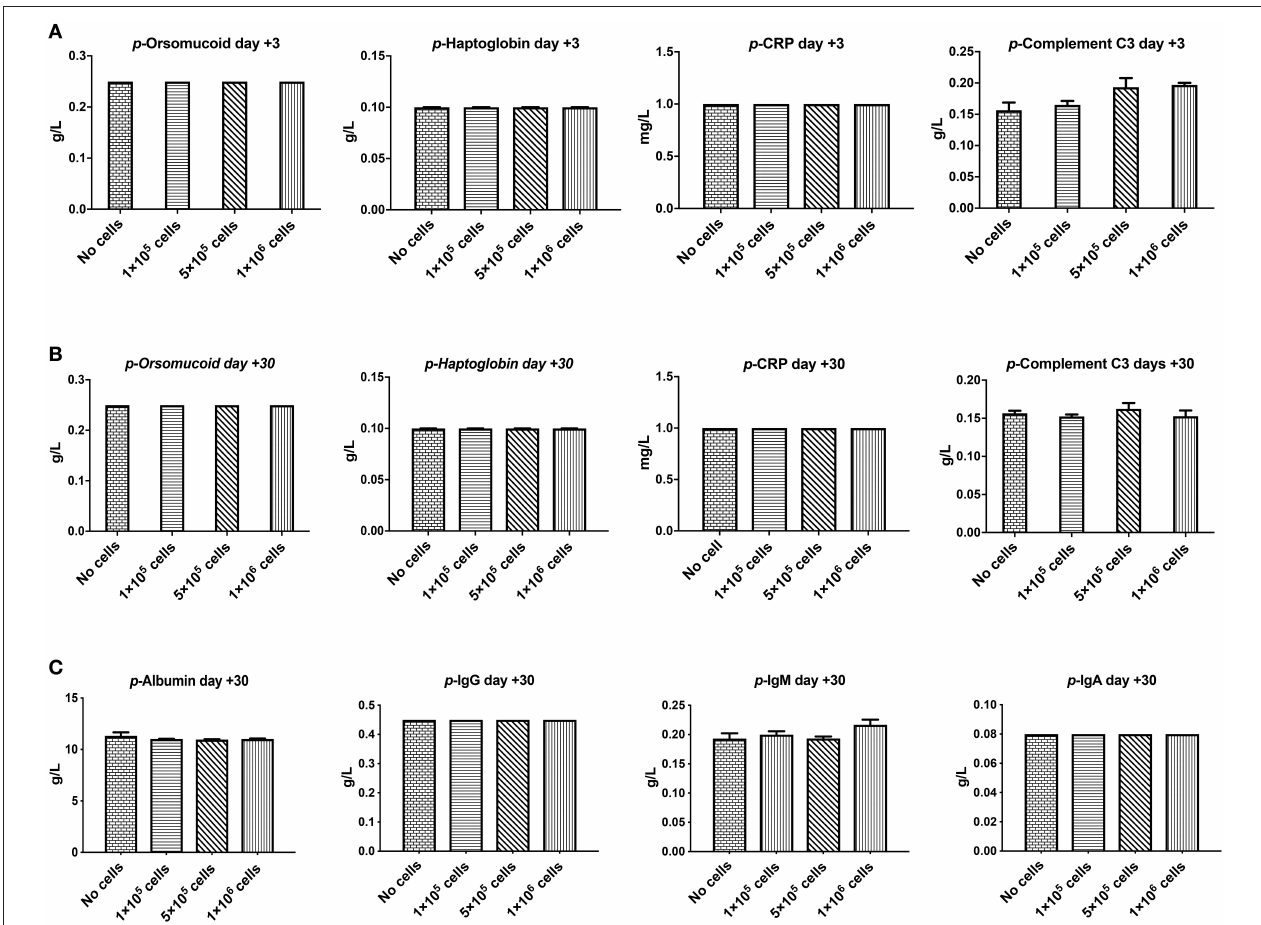
FIGURE 3 | The effect of human DSCs infusion on the inflammatory markers, serum proteins level. Early and delayed inflammatory reaction could be an important and relevant side effect following systemic cell therapy. Healthy mice received human DSCs i.v. at different doses (0–1 × 10 6 cell/mouse) ( N = 3–5 mouse per dose/timepoint). (A–C) The acute inflammatory reactions’ protein as well as serum level of immunoglobulin and albumin were measured and showed no significant changes in the short ( + 3 days after) or the long term ( + 30 days after) follow